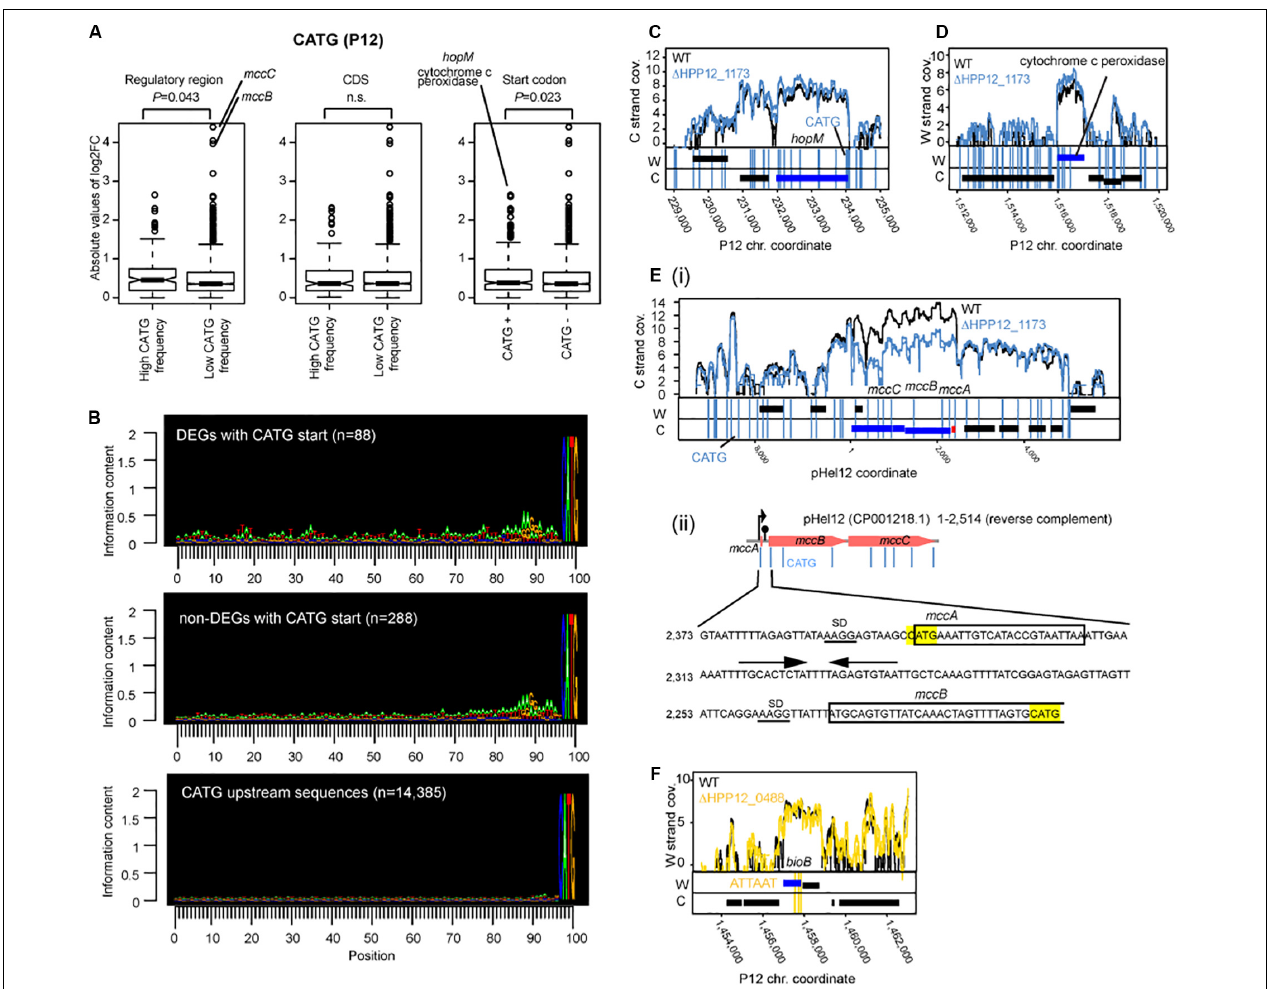
FIGURE 5 | Effects of M.HpyPI (CATG) knockout on transcriptome. (A) Genes with high CATG motif abundance in the regulatory region or genes starting with CATG motif tend to be affected. Transcript abundance change was compared between two groups. The upstream 149 bp from the coding region was defined as the regulatory region. Statistical significance of the difference was evaluated by one-tailed Wilcoxon’s rank sum test; n.s.: P > 0.05. CDS, coding sequence. (B) Sequence conservation in the upstream region of CATG-starting genes. Conservation level was presented using Seqlogo (Schneider and Stephens, 1990). (C) Large transcript changes in hopM . (D) Large transcript changes in cytochrome c peroxidase gene. (E) (i) Large transcript changes in mccB and mccC genes for microcin on a plasmid. (ii) nucleotide sequence around mccB upstream region. CATG was highlighted in yellow. SD sequences are underlined. Putative terminator sequence (Zukher et al., 2014) were indicated by arrows. (F) Transcript abundance changes, upon M.HpyPVII knockout, in the bioB gene ending with three copies of ATTAAT. A blue box indicates a differentially expressed gene. A vertical line indicates a copy of a methylation